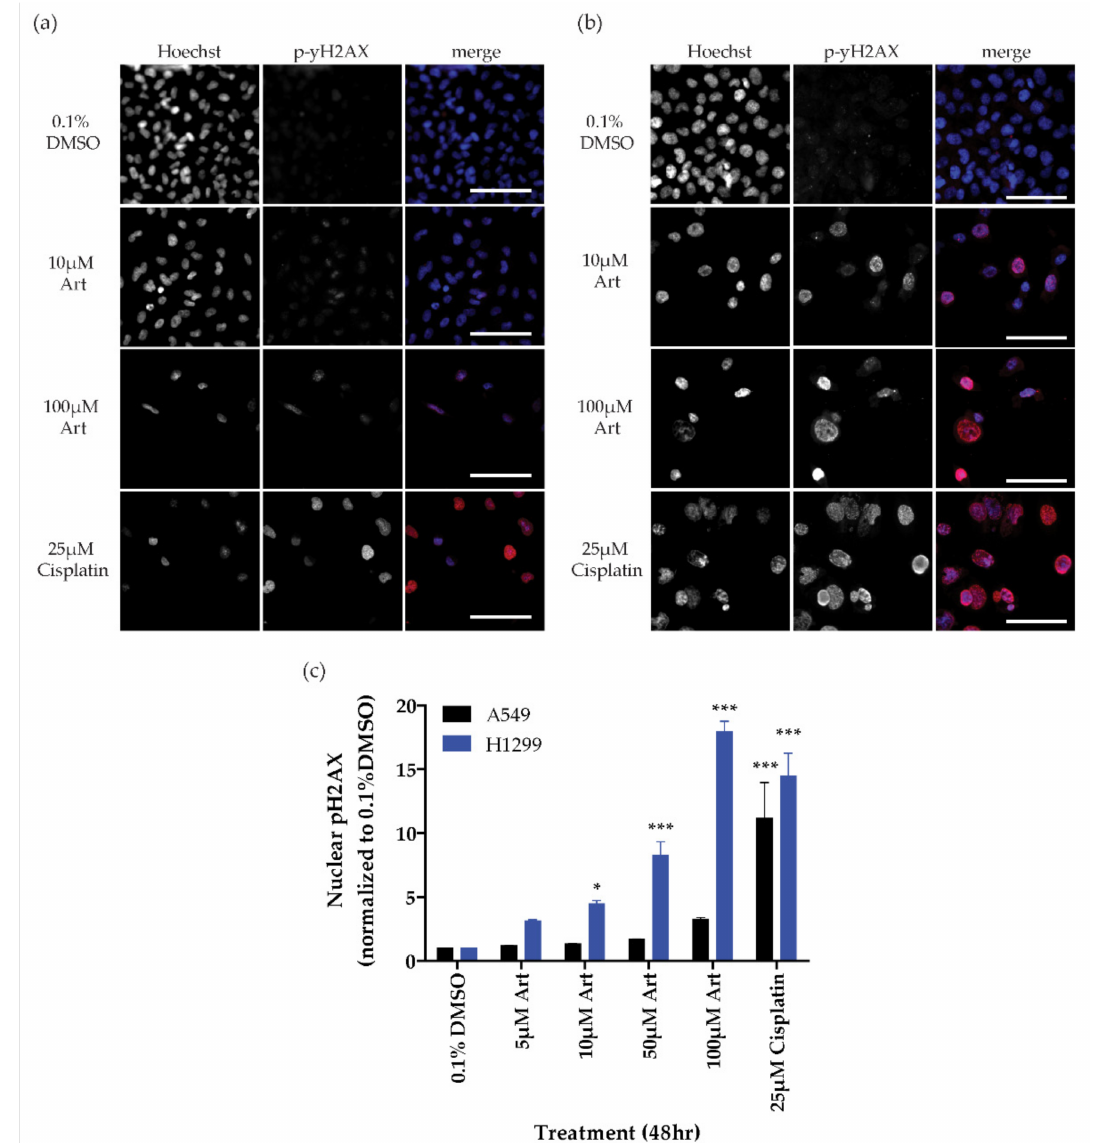
Figure 2. Dose-dependent induction of DNA damage by artesunate in NSCLC cell lines. Representative images for A549 cells ( a ) and H1299 cells ( b ) treated for 48 h with the indicated drug concentration (bar = 50 µ m). ( c ) Quantification of nuclear pH2AX staining. Graphed as mean fold change in nuclear fluorescent intensity signal normalized to 0.1% DMSO per cell ± SD. p -values calculate by one-way ANOVA for each cell line with Dunnett’s multiple comparison test comparing to matched 0.1% DMSO control (* p < 0.05, *** p <